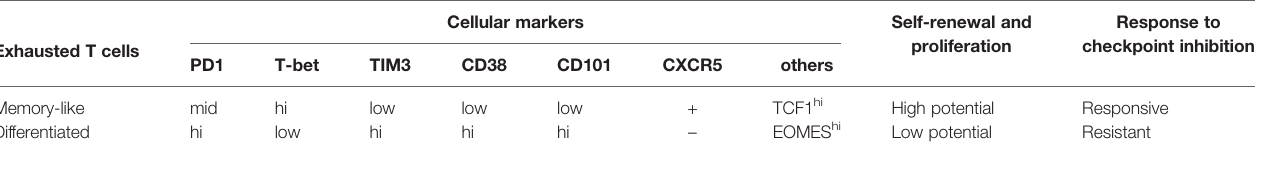
TABLE 1 | Extensive heterogeneity in exhausted T cell